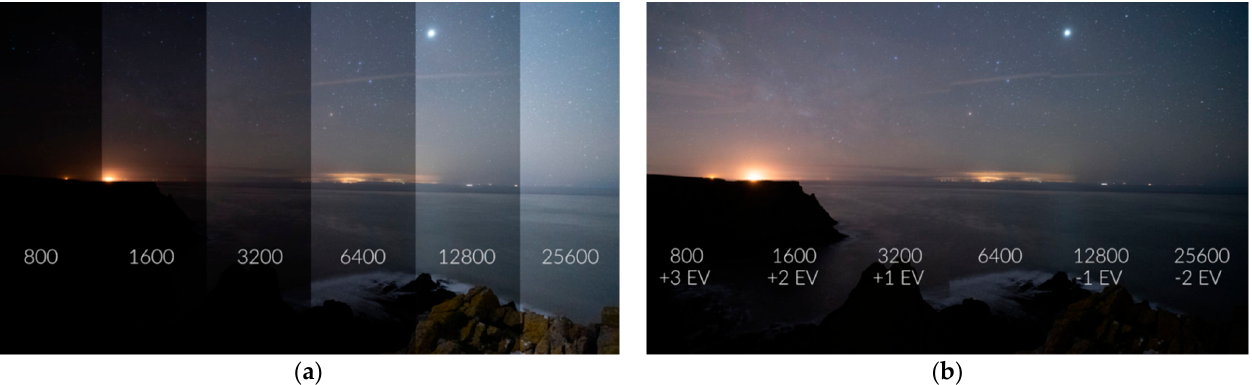
Figure 13. ( a ) ISO Invariant Sony Camera at different ISOs; ( b ) exposure compensated for in post- processing.